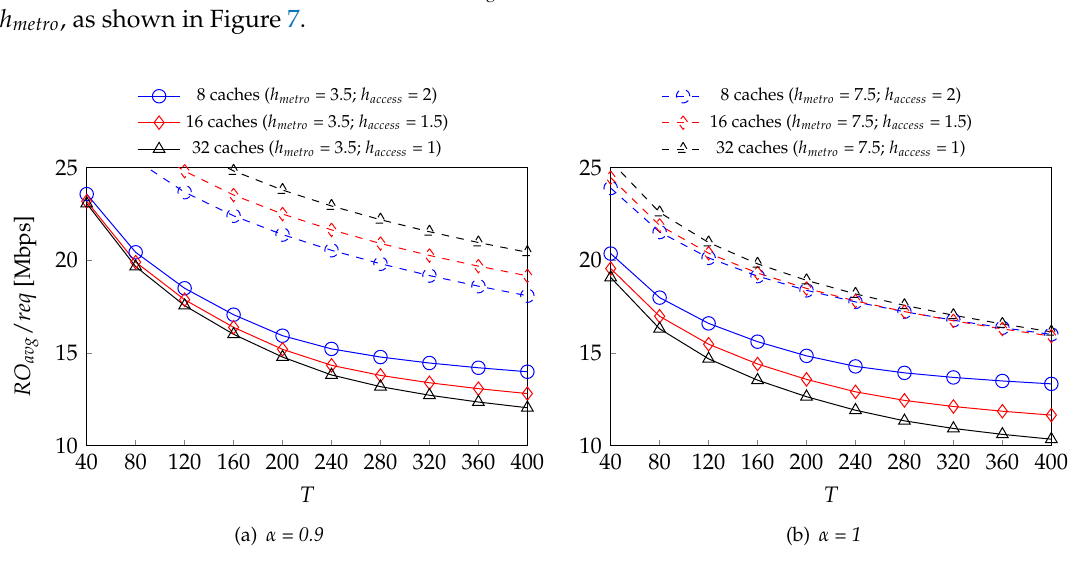
Figure 7. Average resource occupation RO avg / req for increasing value of total allowed storage capacity for α = 0.9 and